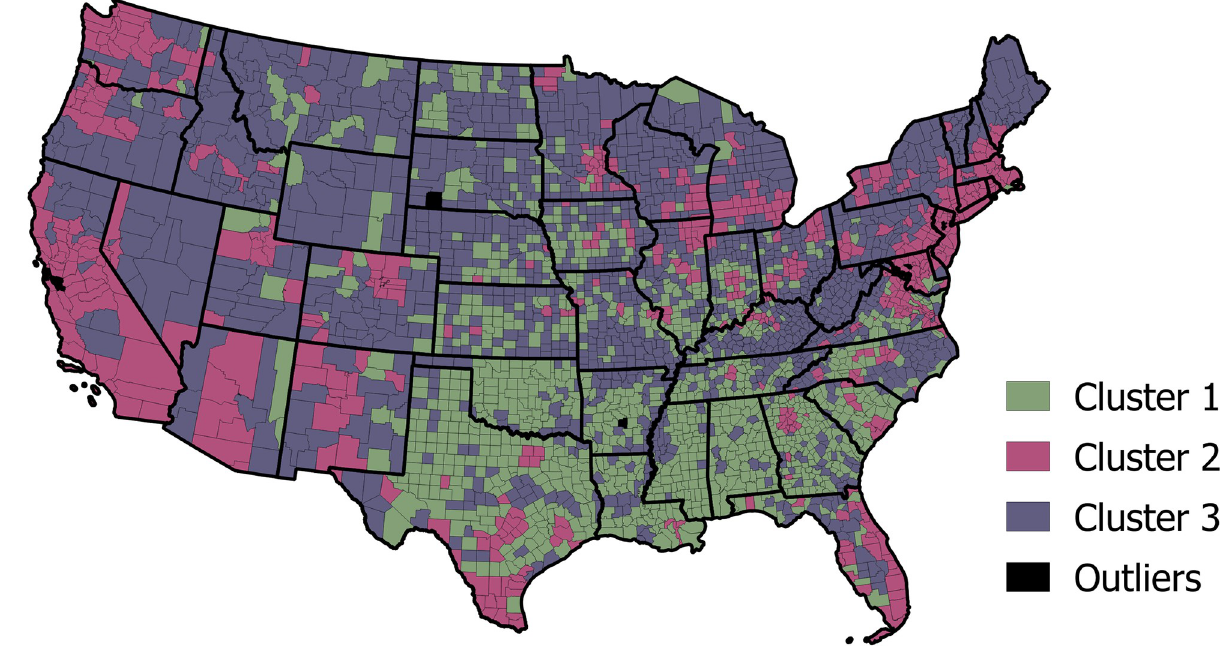
Fig 8. K-means analysis mapped geographically. Map produced in QGIS [30] using SafeGraph [3] derived data, shapefile from data.gov [31].